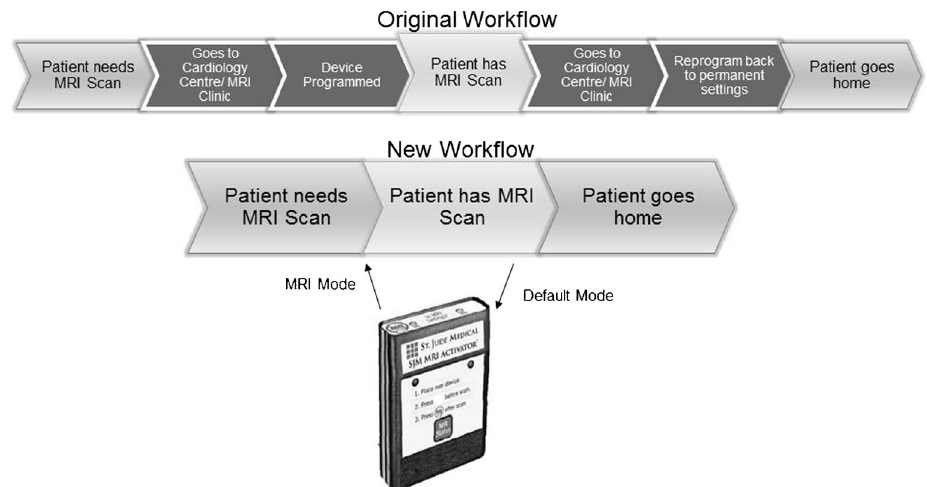
Fig. 5 Flowchart demonstrating a streamlined workflow with the incorporation of a hand-held ex- ternal activator (St Jude Medical, used with